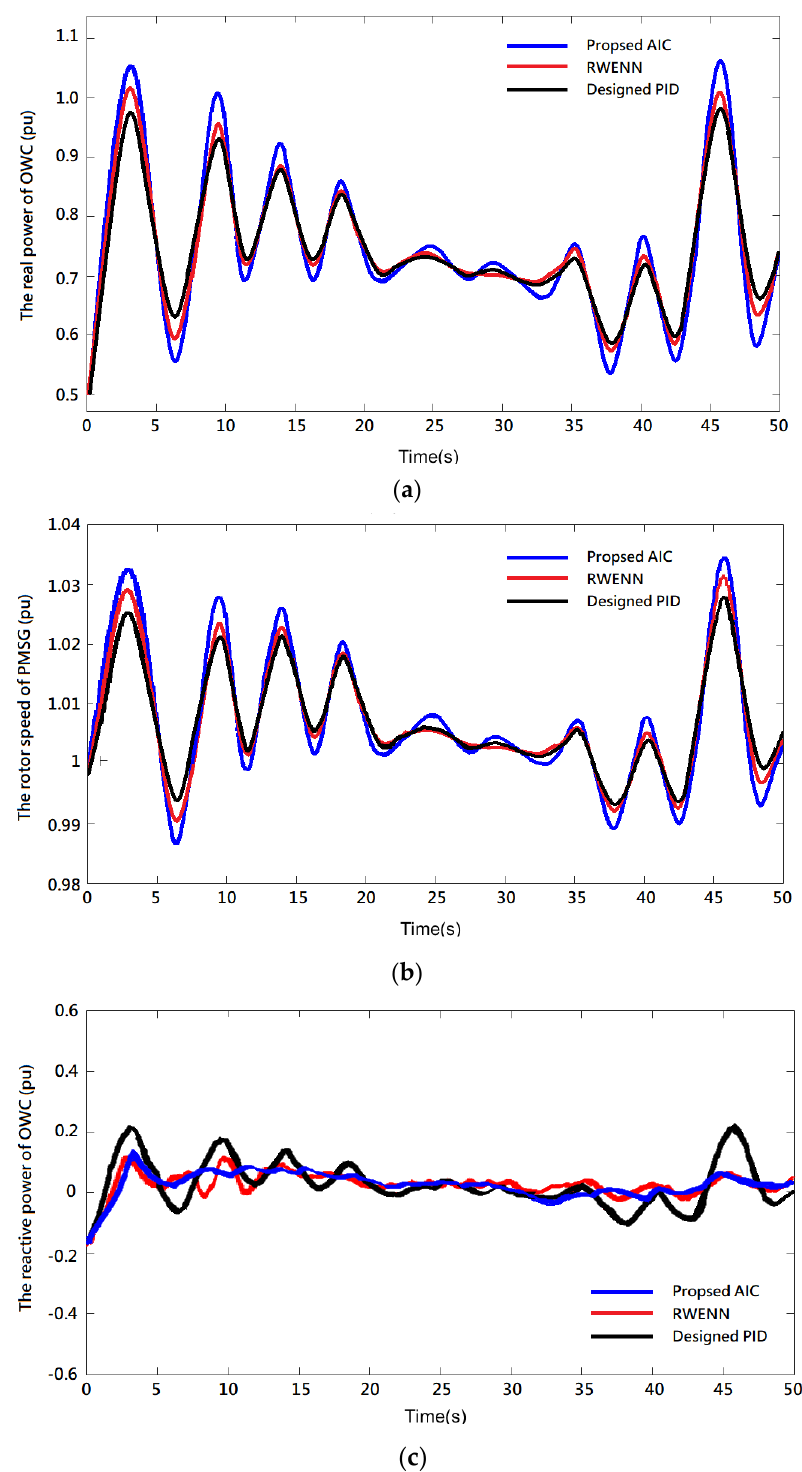
Figure 4. The PMSG output power transient responses of the OWC system: ( a ) response of the real power, ( b ) response of rotor speed, and ( c ) response of the reactive power.